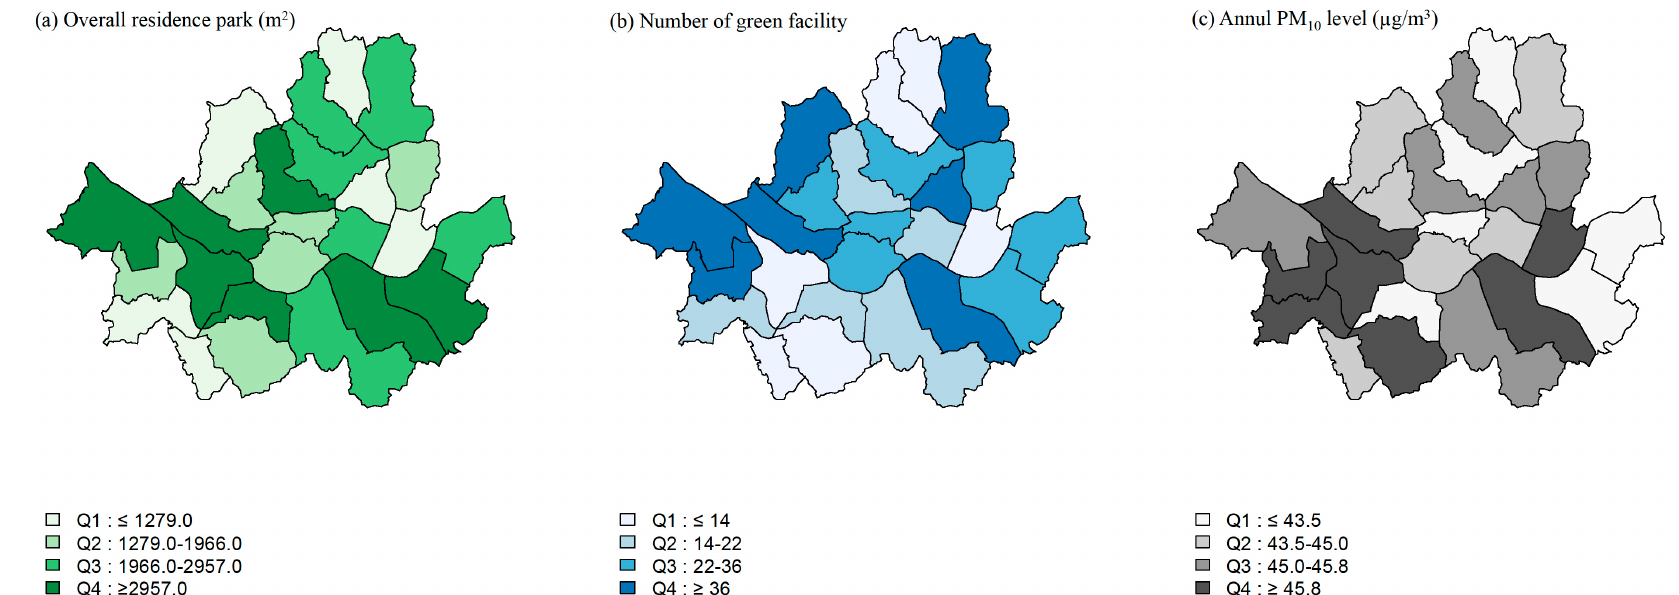
Figure 1. Quartile distribution of residence park, number of green facilities, and annual PM 10 levels among 25 communities in Seoul, Korea, 2013.